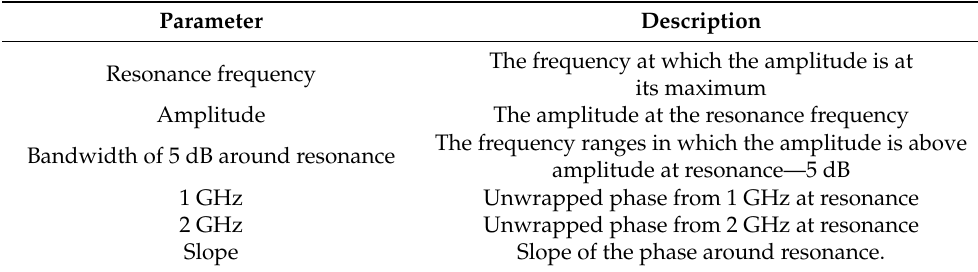
Table 1. Parameters from the MAS measurements. Parameter Description Resonance